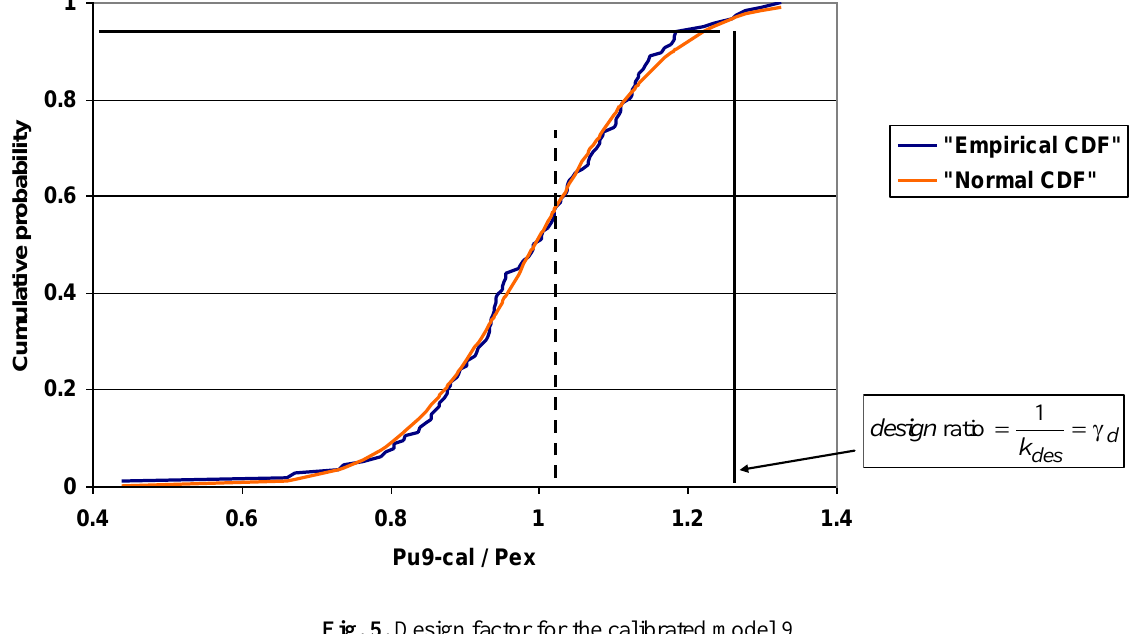
Fig. 5. Design factor for the calibrated model